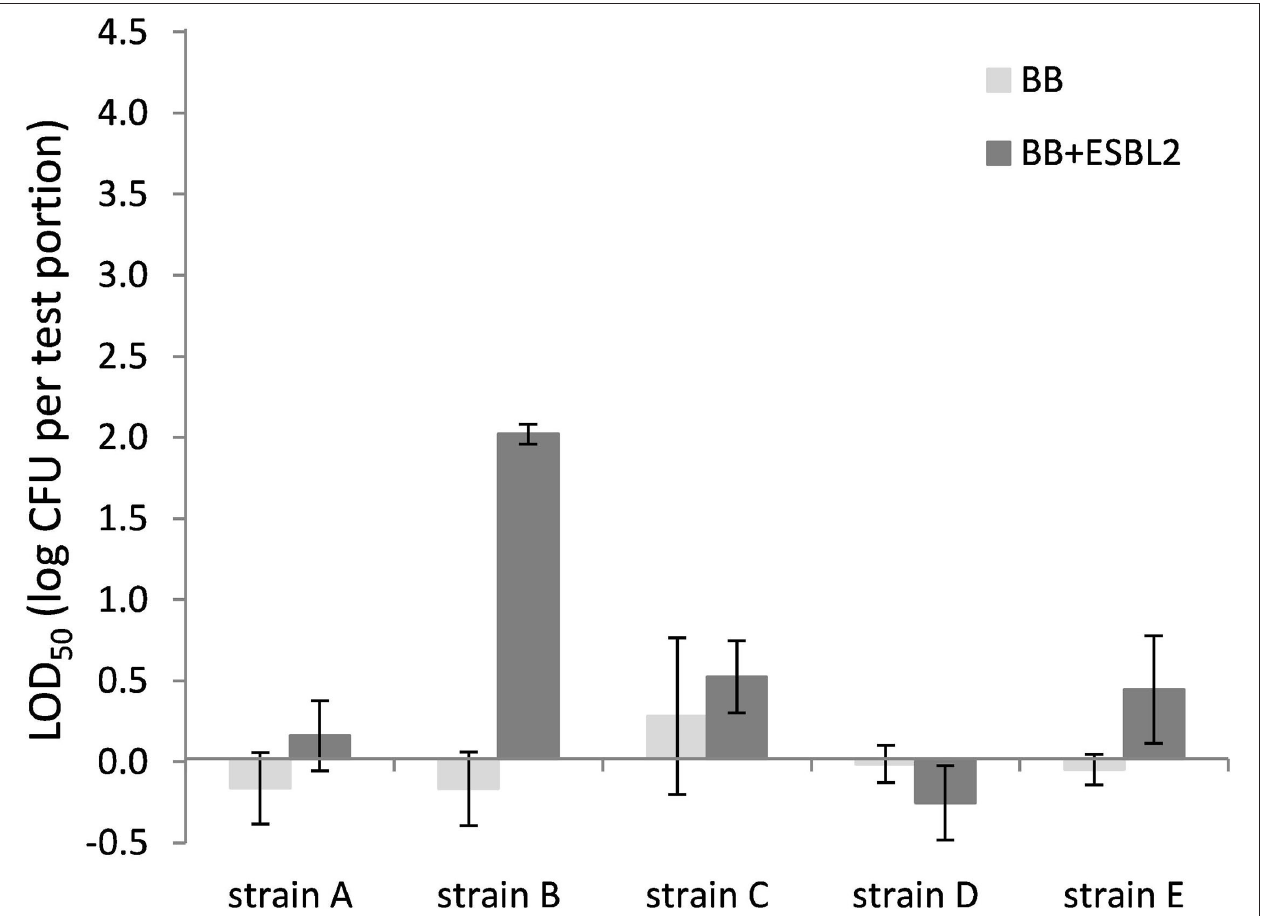
FIGURE 4 | LOD 50 of C. jejuni strains A, B, and D and C. coli strains C and E. Enrichment in Bolton broth ( n = 2–5) and with co-inoculation of E. coli ESBL 2 ( n = 2–3) in chicken skin (irradiated before use). Error bars indicate the standard